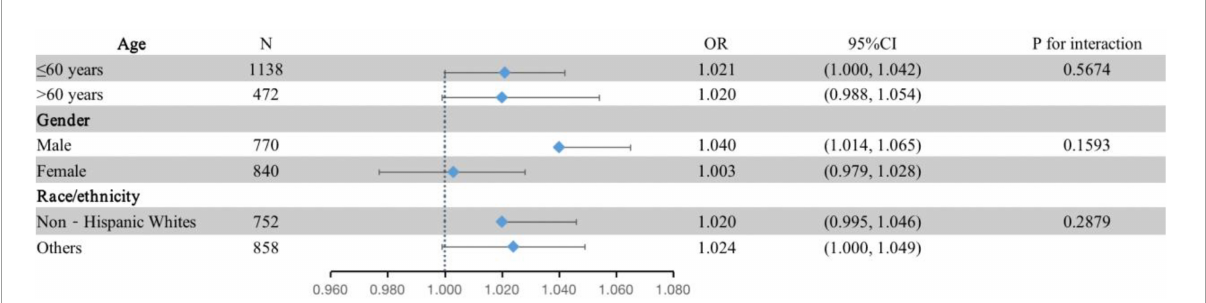
FIGURE1 Subgroup analyses of the associations between the tertiles of plasma EA and moderate/severe periodontitis by age, gender and race/ethnicity in the discovery dataset (NHANES 2009–2010; n = 1,610). The adjustment model was the same as model III in Table 2 except that the covariates tested as effect modifiers were not adjusted. Periodontitis is defined by the CDC/AAP case definition.